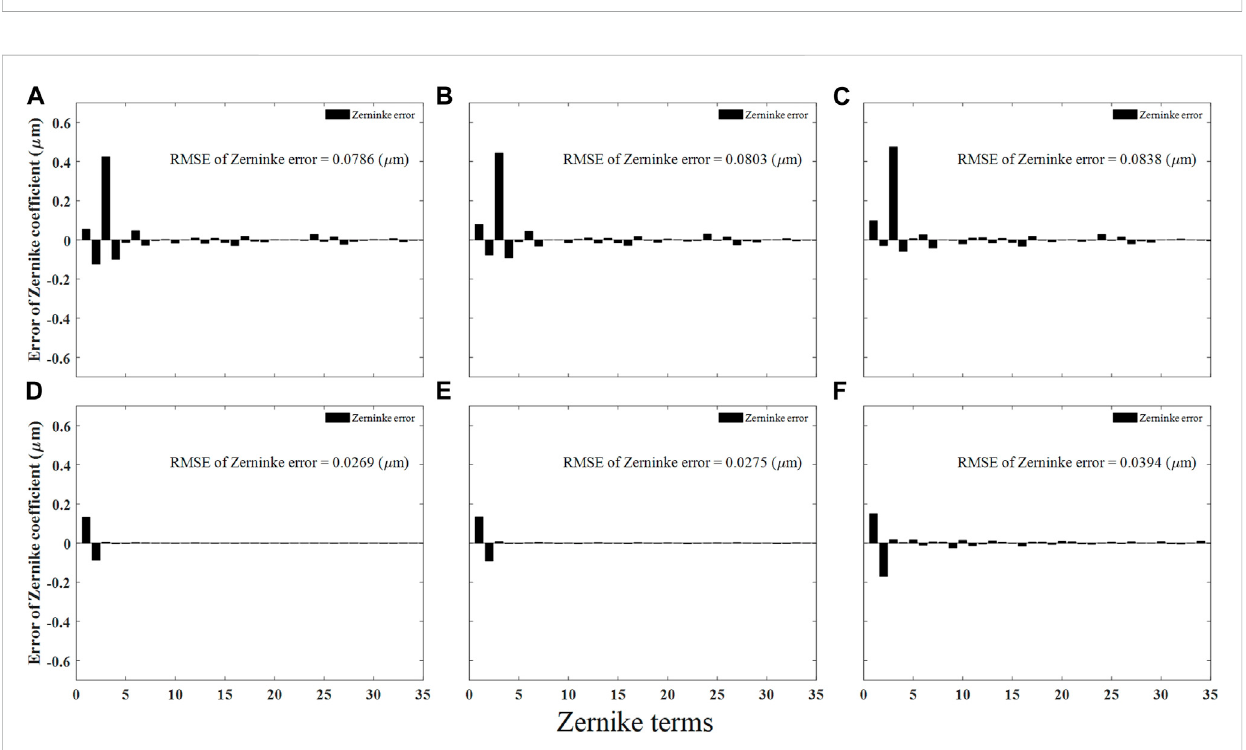
FIGURE 11 Zernike coef fi cient error restored by traditional method (A – C) and polarization detection method (D – F) under different noise levels.